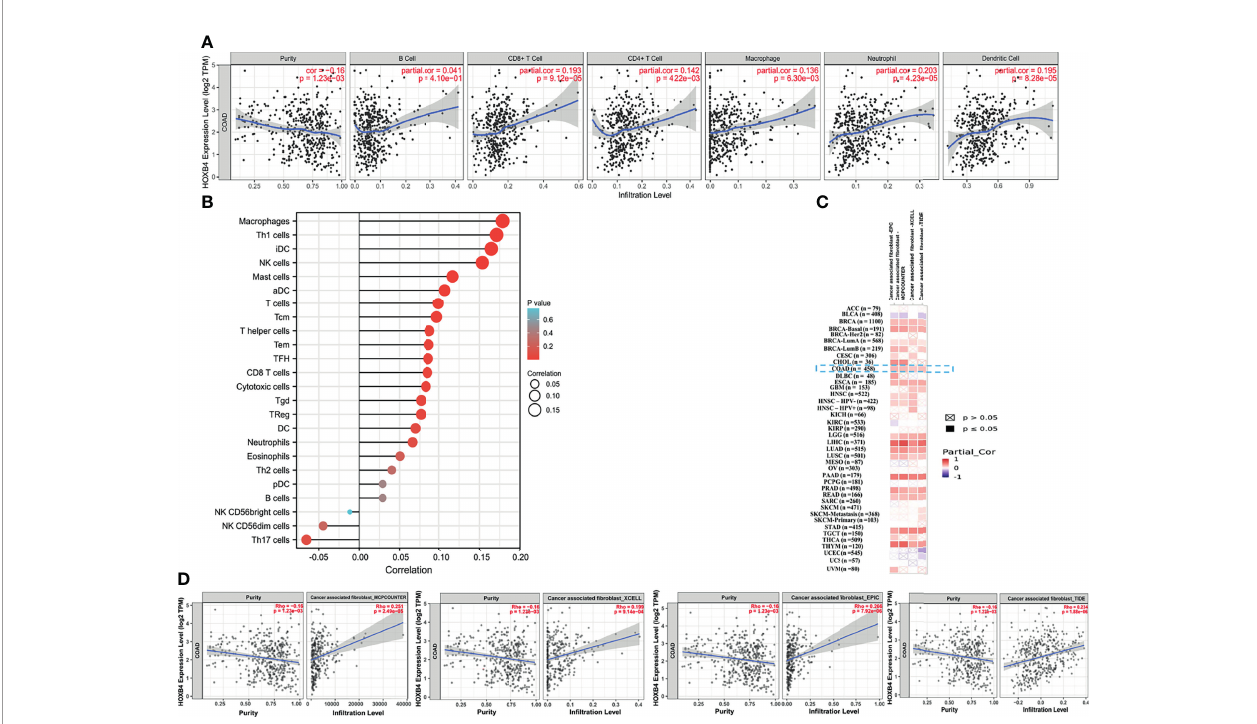
FIGURE 6 | Correlation between HOXB4 expression level and the level of immune in fi ltration in COAD. (A, B) Correlation between HOXB4 expression and the in fi ltration level of different immune cells in colon adenocarcinoma with the TCGA. (C, D) Correlation between HOXB4 expression and immune in fi ltration of cancer- associated fi broblasts across all types of cancer in TCGA. COAD, colon